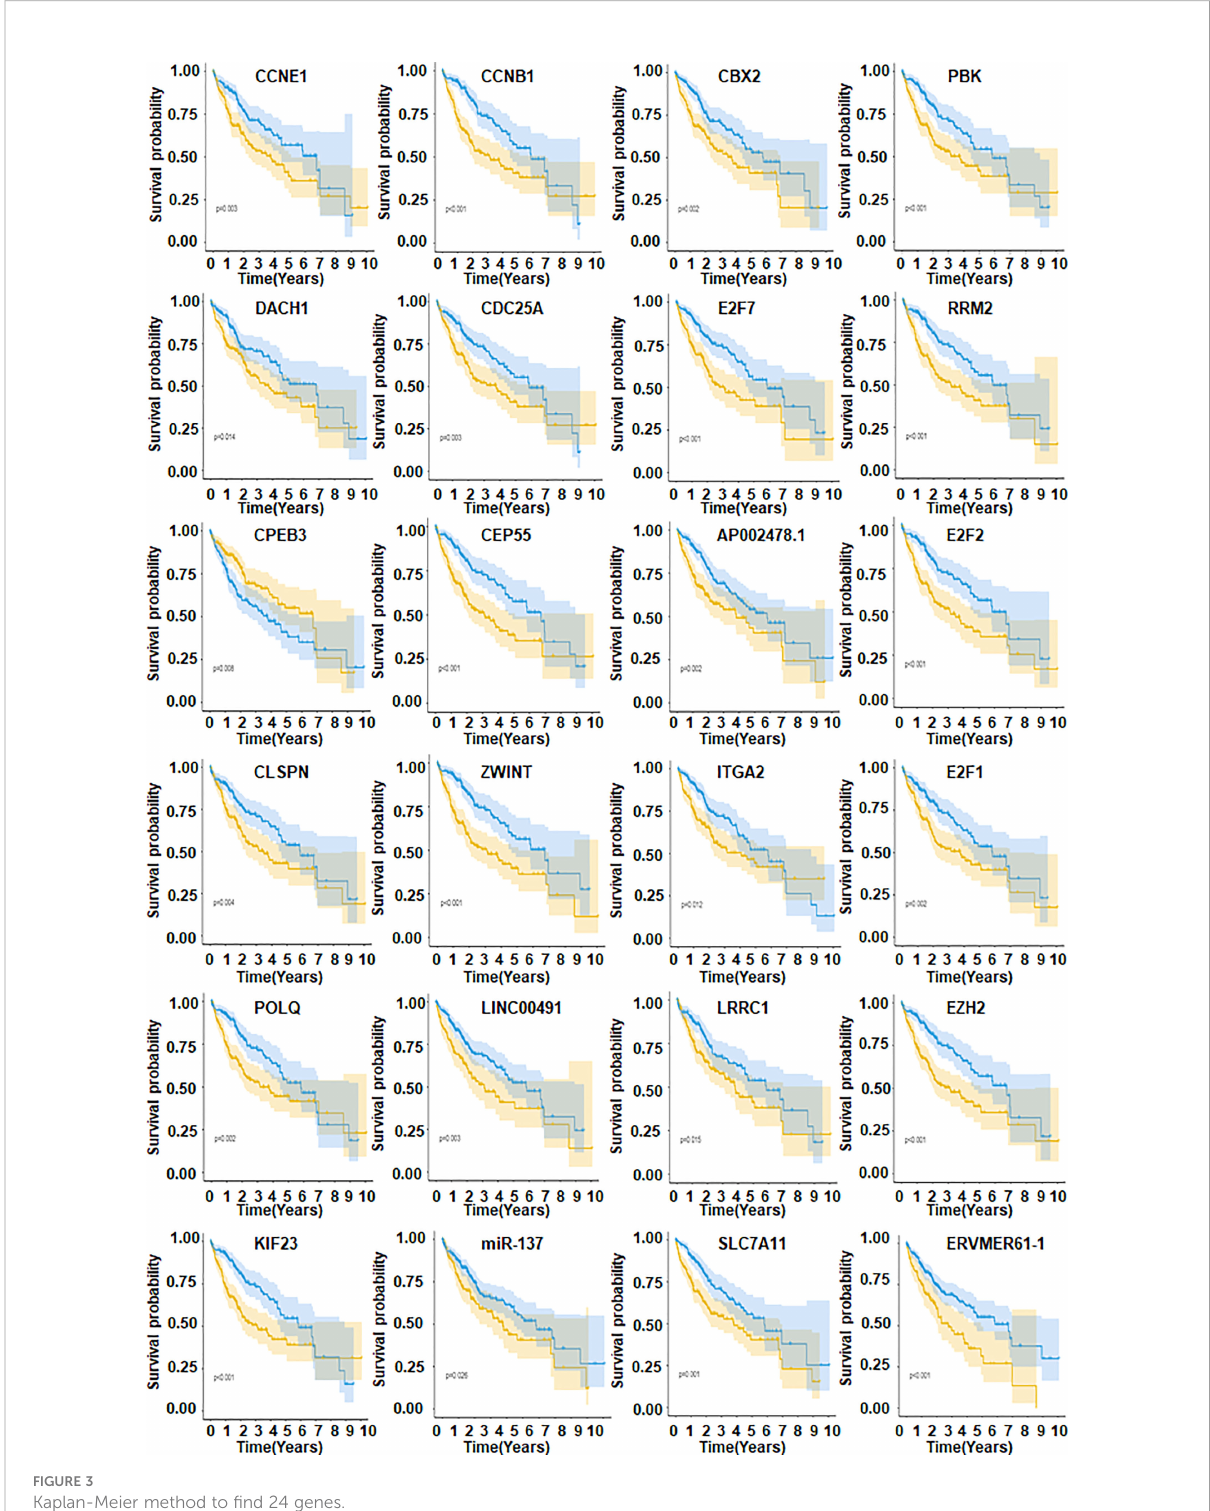
FIGURE 3 Kaplan-Meier method to fi nd 24